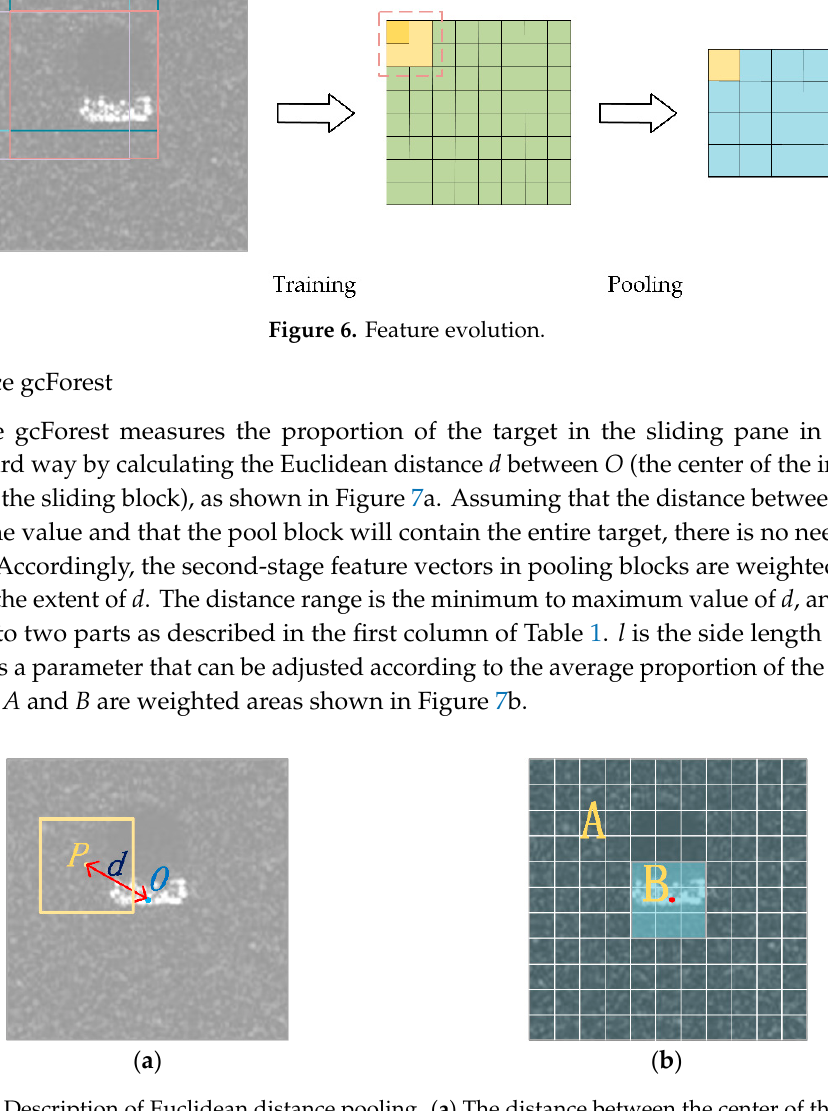
Figure 7. Description of Euclidean distance pooling. ( a ) The distance between the center of the image and the center of the pane; ( b ) the weight range partition diagram. Table 1. Weights for di ff erent distance